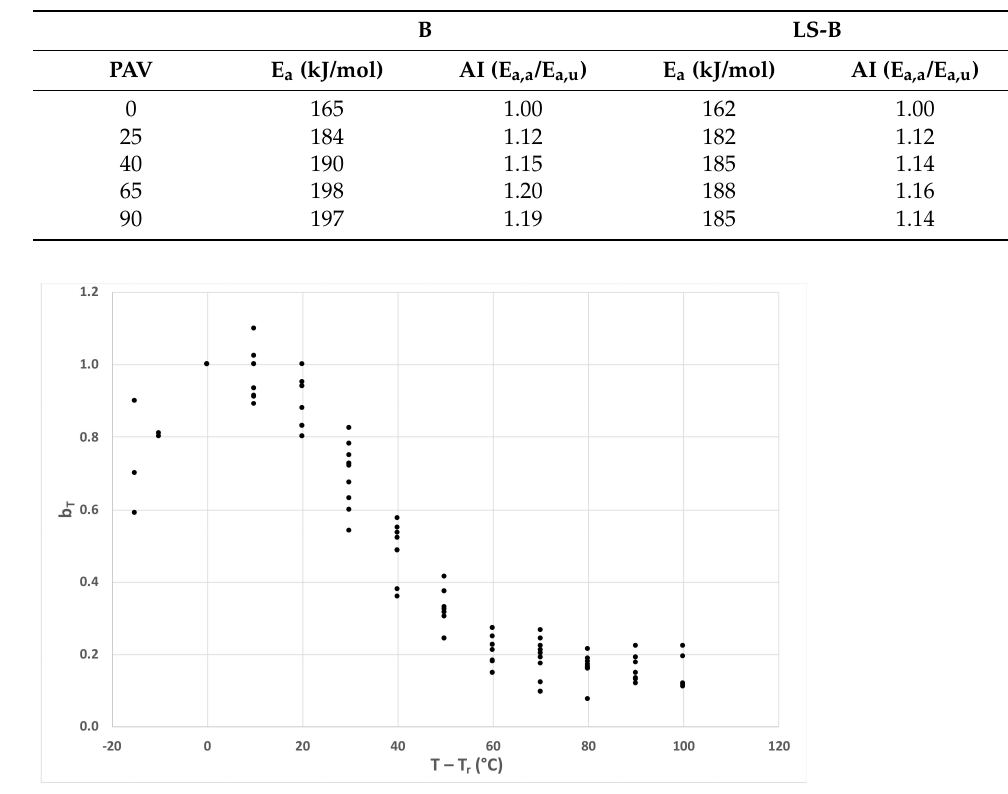
Figure 5. Vertical shift factors as a function of temperature for the 10 binders.